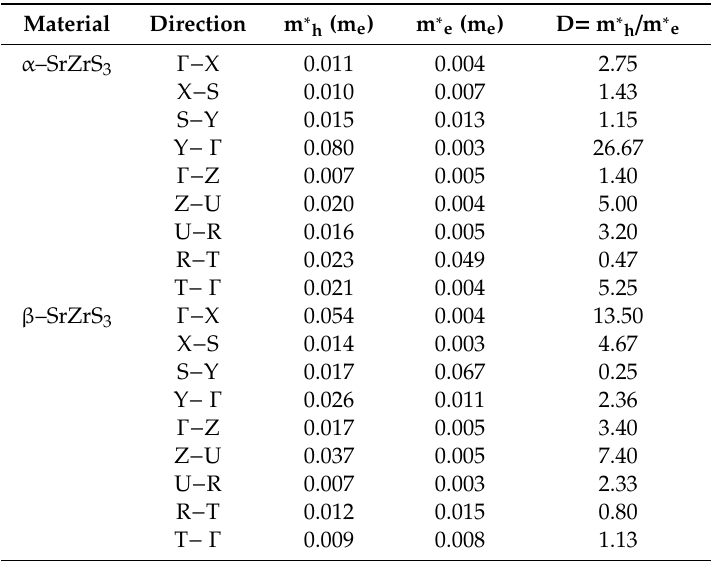
Table 3. Calculated hole (m ∗ h ) and electron (m ∗ h ) e ff ective masses of α –SrZrS 3 and β –SrZrS 3 along high symmetry